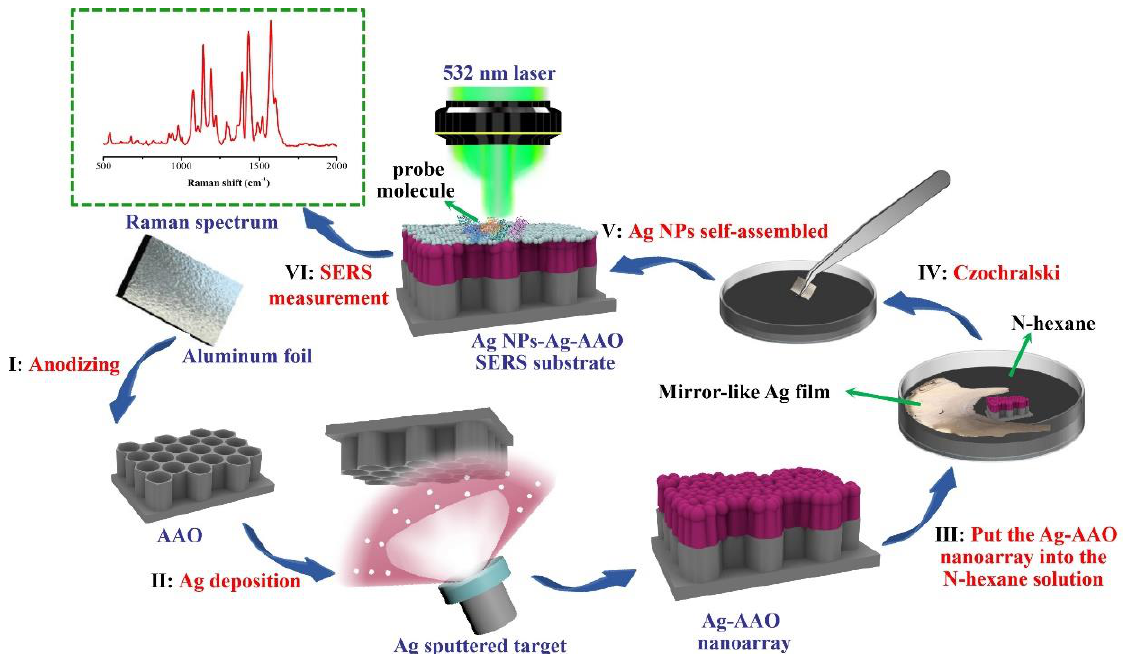
Figure 1. Schematic illustration of the fabrication process of the Ag NPs-Ag-AAO nanoarray and the SERS measurement by the Raman system.